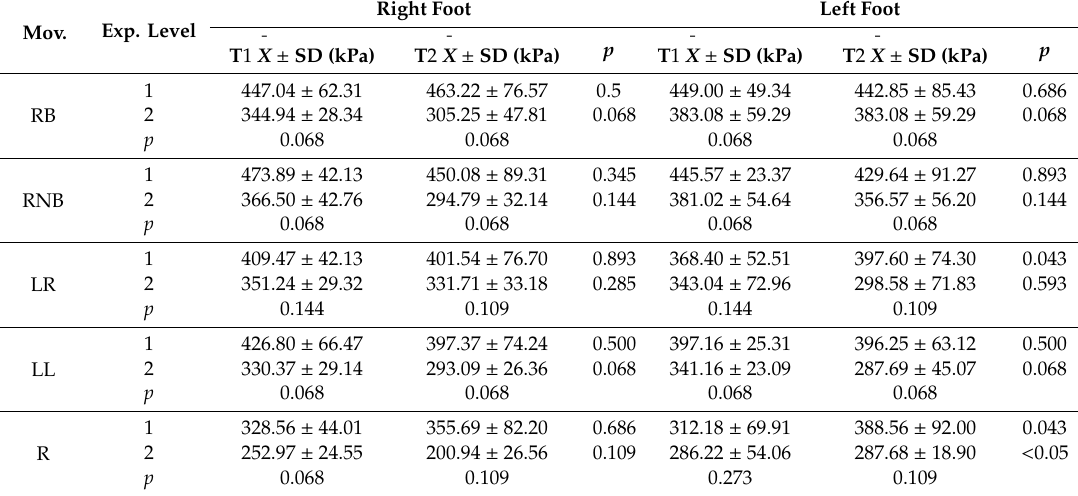
Table 6. Results considering the two experience levels for the five movements (Mov) at T1 and T2. Right Mov. Exp. Level